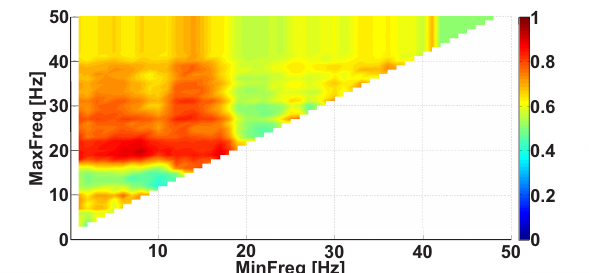
Figure 15. An example of the Frequency AUC diagram. The PSD of the considered wave trains is no less than 30 µ V 2 / Hz. The abscissa axis indicates the lower bound of the frequency range; the ordinate axis indicates the upper bound of the frequency range. A bright red area is observed in the frequency range along the abscissa; the y-coordinate is equal to approximately 20 Hz. The brightest red point has coordinates: 8 Hz and 20